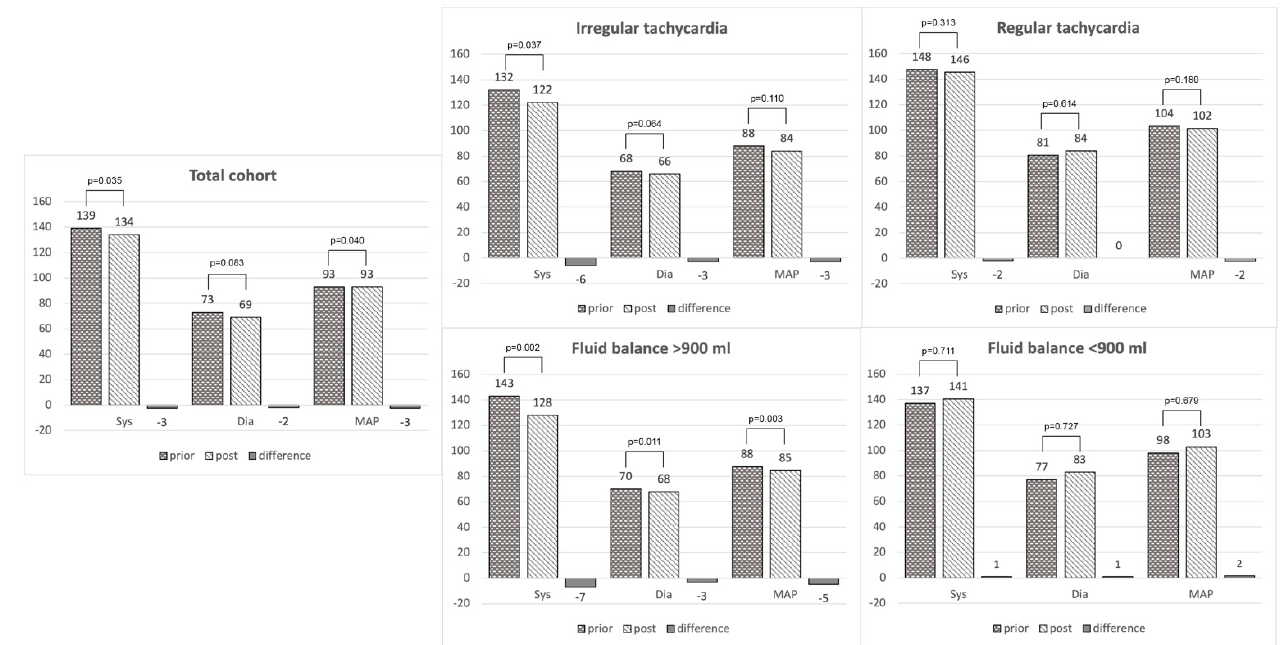
Figure 2. Hemodynamic profiles pre- and post-five minutes after push-dose Landiolol application. Blood pressure values are stated as medians (sys = systolic, dia = diastolic, MAP = mean arterial pressure) and are given in millimeters mercury (mmHg). The fluid balance accounts for the overall balance right before push-dose Landiolol application. “Irregular tachycardia” and “regular tachycardia” concerns the heart rhythm before the bolus